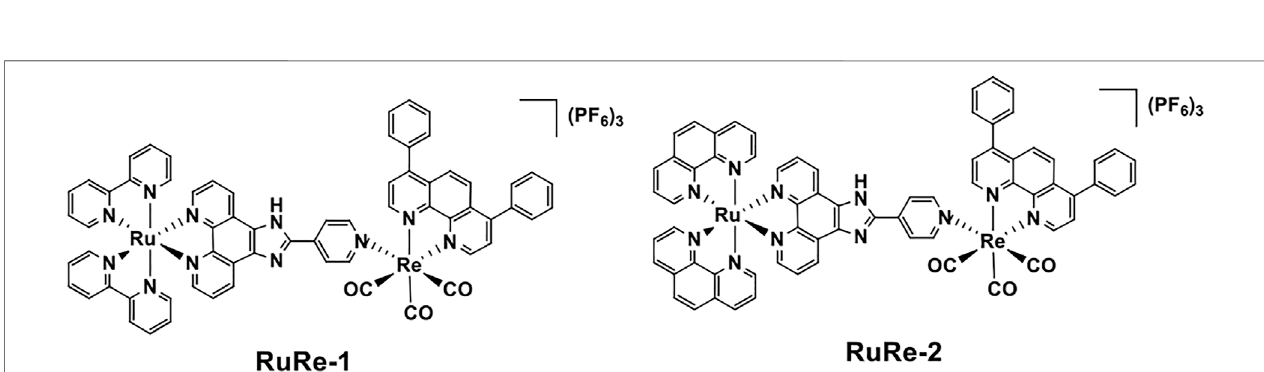
FIGURE 8 |(A) Woundhealing ofHeLa cells after treated with RuRe-1 (3.1 μ M) and RuRe-2 (2.5 μ M) for 0, 24, and 36 h. (B) Quantitative data of wound-healing. Wound closure (%) = [1 − (width at indicated time)/(width at 0 h)] × 100%. (C) Inhibition of colony formation by RuRe-1 and RuRe-2 . (D) Quantitative data of colony formation